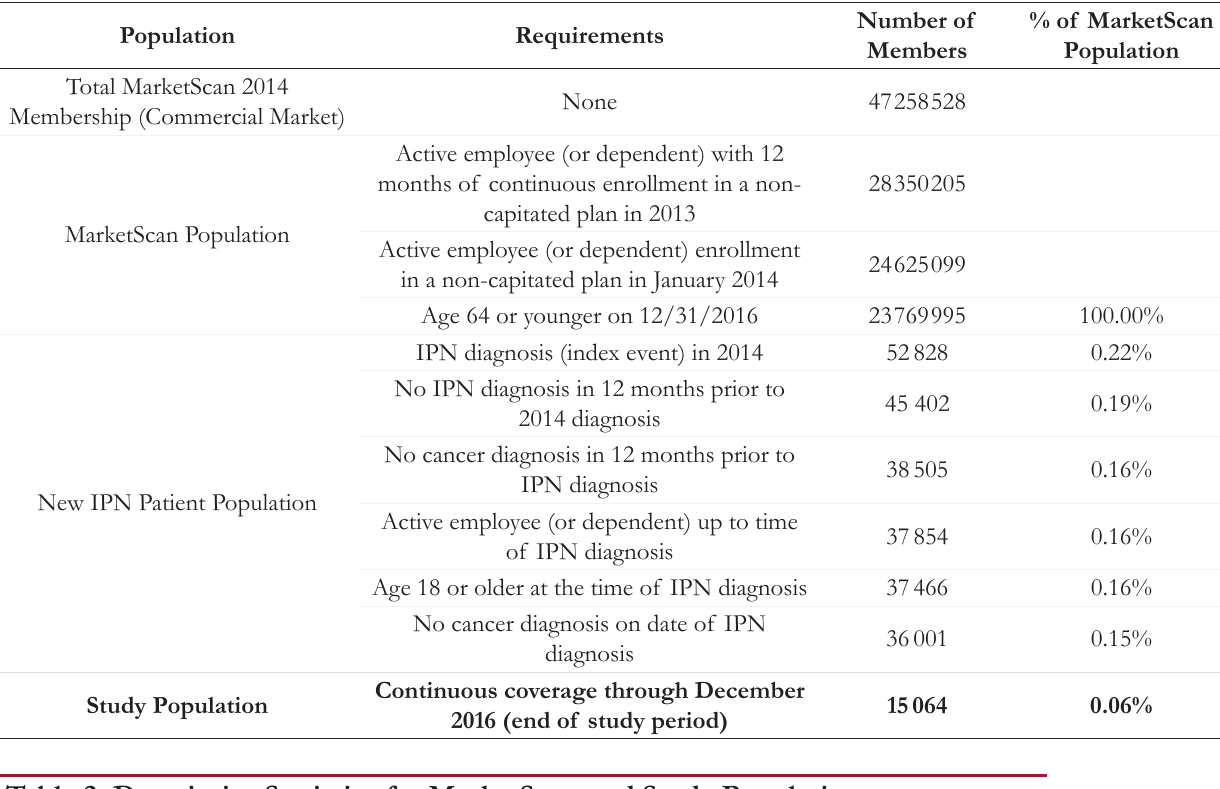
Table 2. Descriptive Statistics for MarketScan and Study Populations